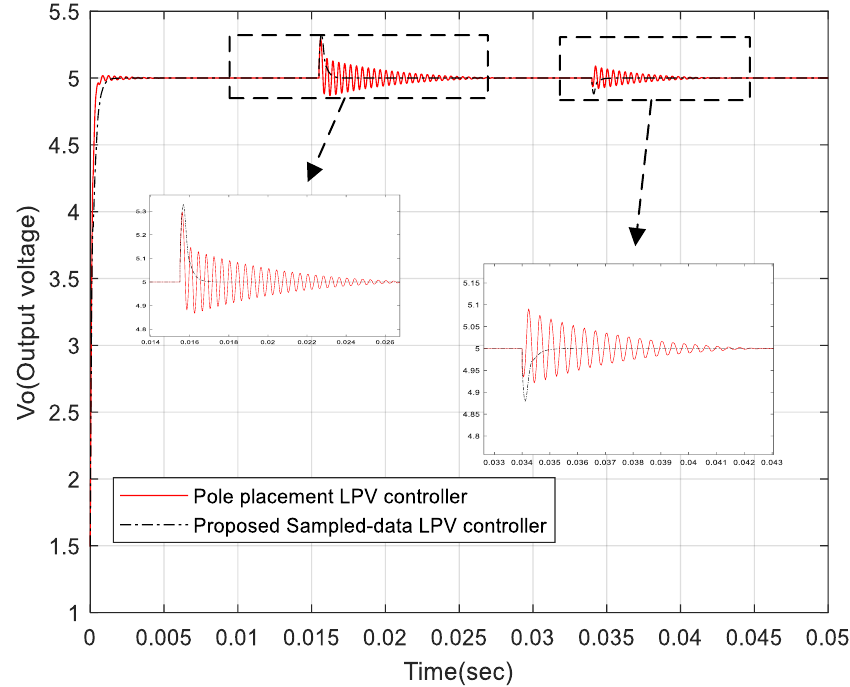
Figure 2. Comparison between output voltage regulation about the equilibrium point under the proposed controller ( T = 0.0005 s) where the load is